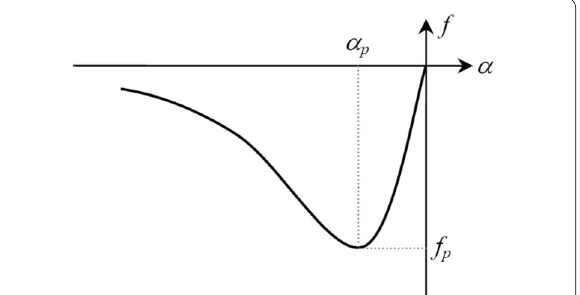
Fig. 17 Thorenfeldt compression curve.